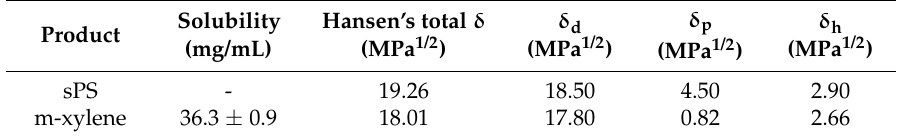
Table 1. Solubility of syndiotactic polystyrene (sPS) and Hansen solubility parameters (HSP)